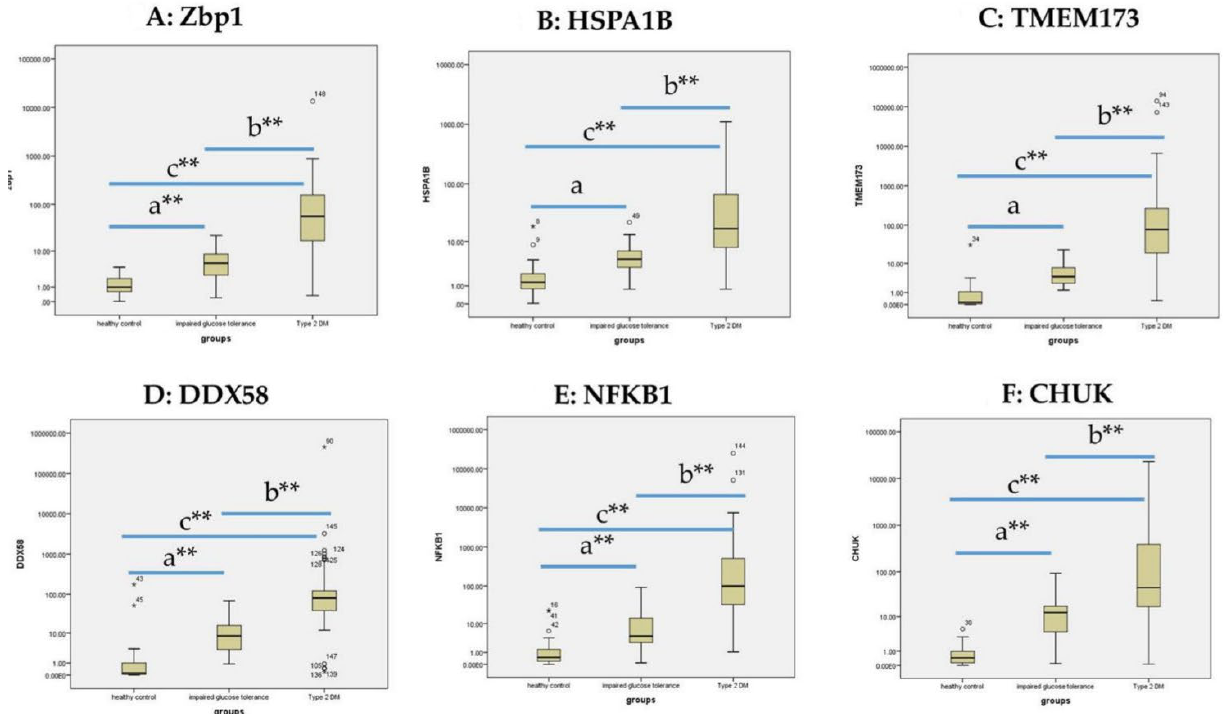
Figure 1. Box plot representing the relative expression of ZBP1, HSPA1B, TMEM173, DDX58, NFKB1 and CHUK mRNAs among all the studied groups. ( A – F ): Boxplot showing the differential expression of the 6 mRNAs among the 3 studied groups and Mann–Whitney test to analyze their expression between each 2 groups. a: The expression of the 6 mRNAs was highly significantly different between the group with pre-DM and the healthy controls. b: High significant difference in the expression of the 6 mRNAs between the T2DM group and the pre-DM group. c: High significant difference in the expression of the 6 mRNAs between the T2DM group and the healthy controls. ** highly significant p < 0.01